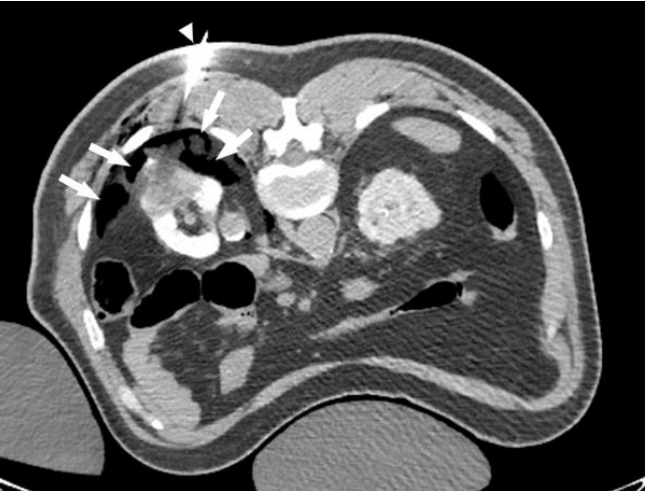
Figure 2. CO 2 dissection. CT scan of the same patient in Figure 1 during ablation. CO 2 has been injected through a 21 g needle (white triangle). Notice that CO 2 (arrows) accumulates in the most posterior, non-dependent, fat planes, creating an insulating plane between the kidney and intercostal nerves.